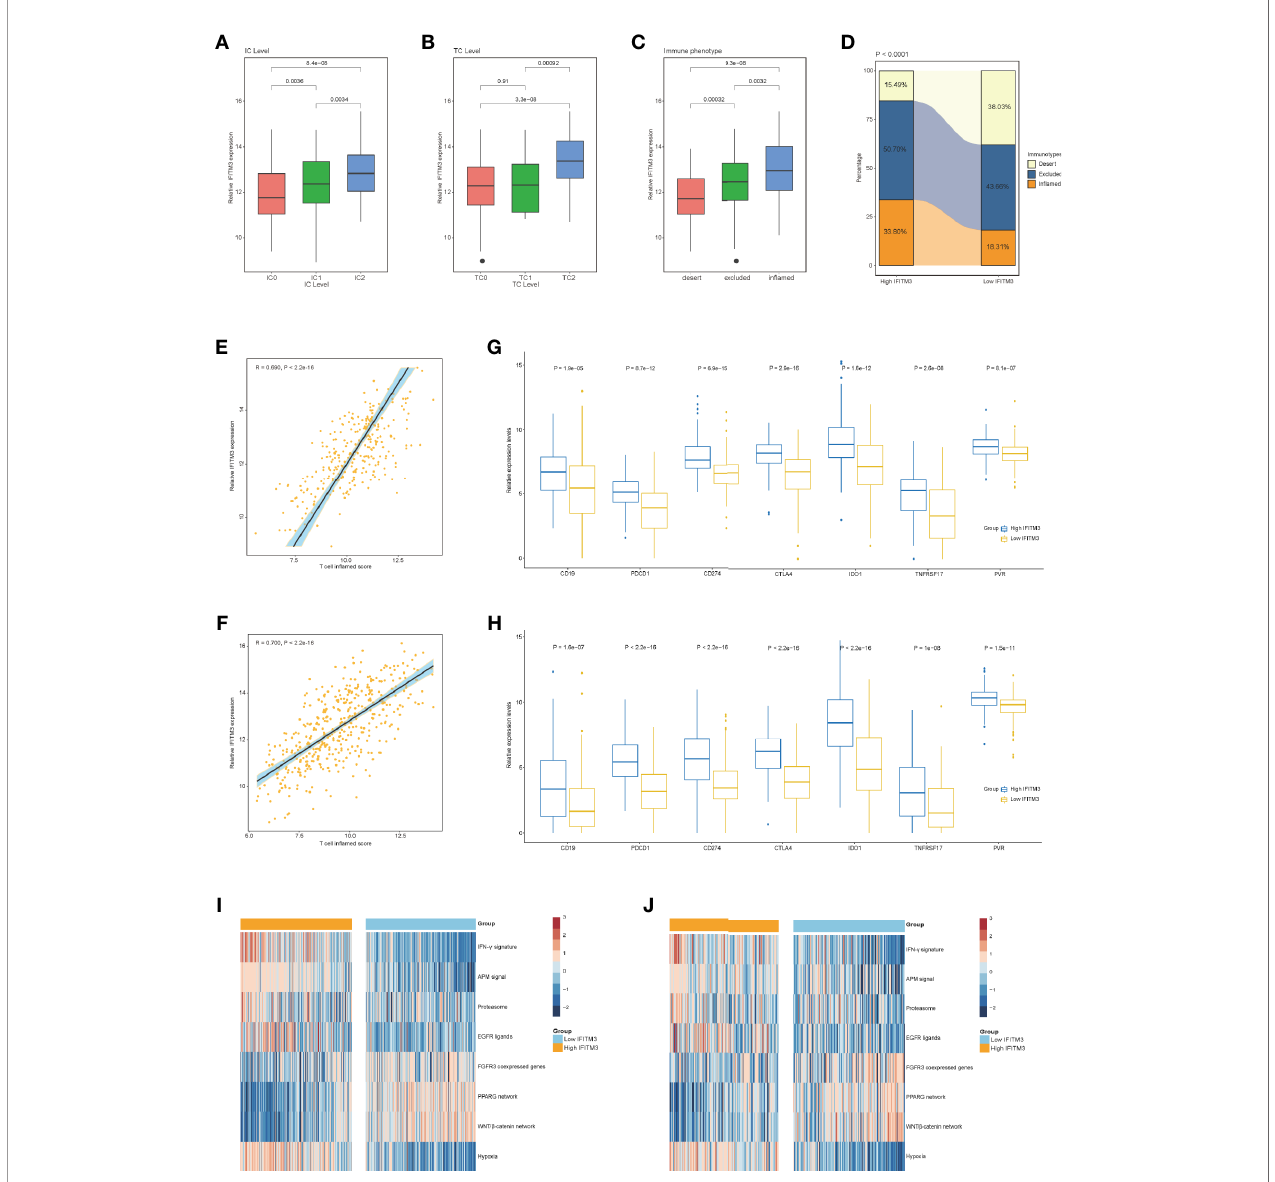
FIGURE 3 | Correlation between IFITM3 and the immune phenotype in BLCA. (A, B) Differences in PD-L1 expression in tumor cells and immune cells between the high- and low-IFITM3 groups in the IMvigor210 cohort. (C) Expression of IFITM3 in all three phenotypes in the IMvigor210 cohort. (D) The proportions of the three phenotypes in the high- and low-IFITM3 groups in the IMvigor210 cohort. (E, F) Levels of T cell in fl amed scores in the high- and low-IFITM3 groups in the TCGA and IMvigor210 cohorts. (G, H) Expression levels of immune-related targets in the high- and low-IFITM3 groups in the TCGA and IMvigor210 cohorts. (I, J) Enrichment scores of several immune-related signatures calculated using the “ GSVA ” R package in the high- and low-IFITM3 groups in the TCGA and IMvigor210